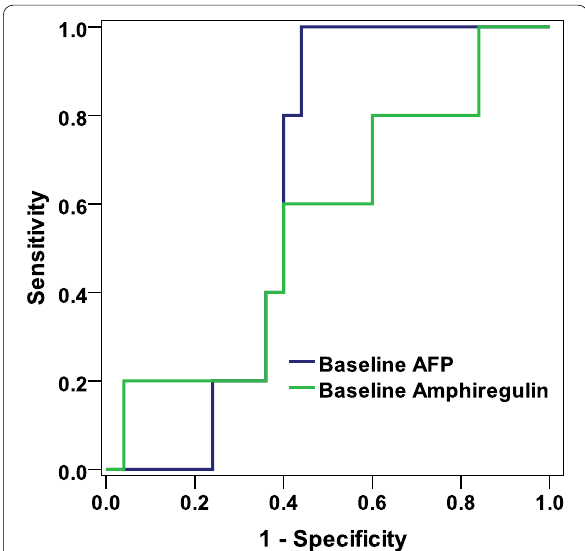
Fig. 2 ROC curve for baseline AFP and amphiregulin in predicting tumor recurrence